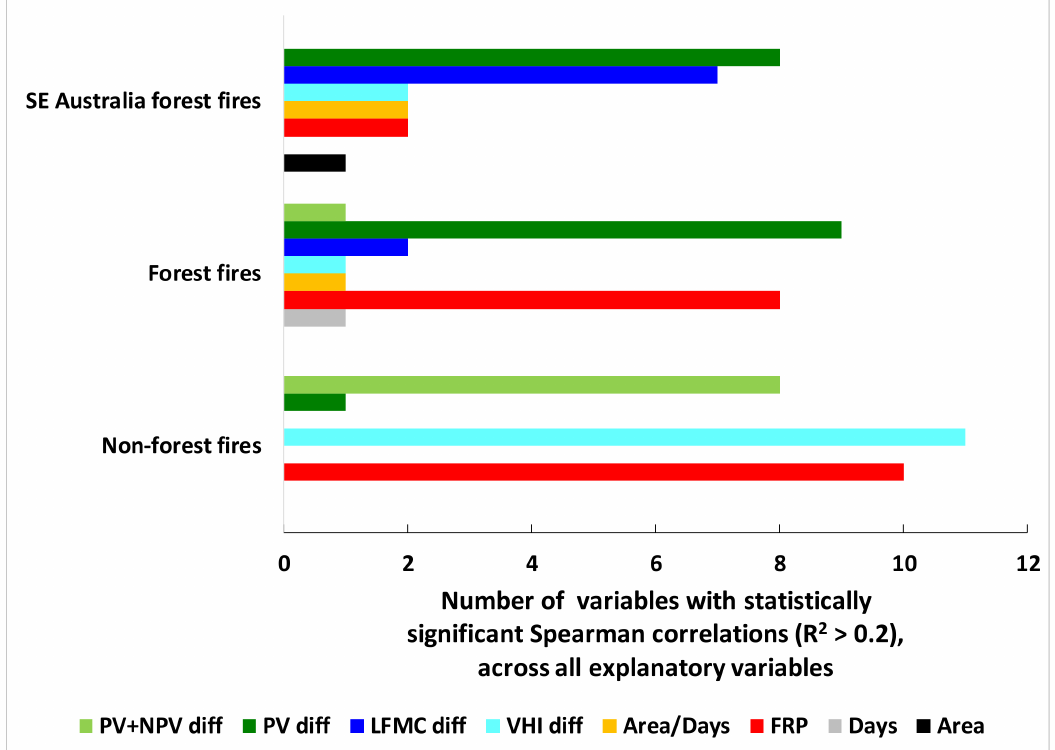
Figure 8. The number of explanatory variables with statistically significant Spearman correlation coefficients (R 2 > 0.2) with the response variables for Black Summer non-forest fires ( n = 186), Black Summer forest fires ( n = 205) and Black Summer forest fires in SE Australia ( n = 63). The variables are summarised here based on the response variables.